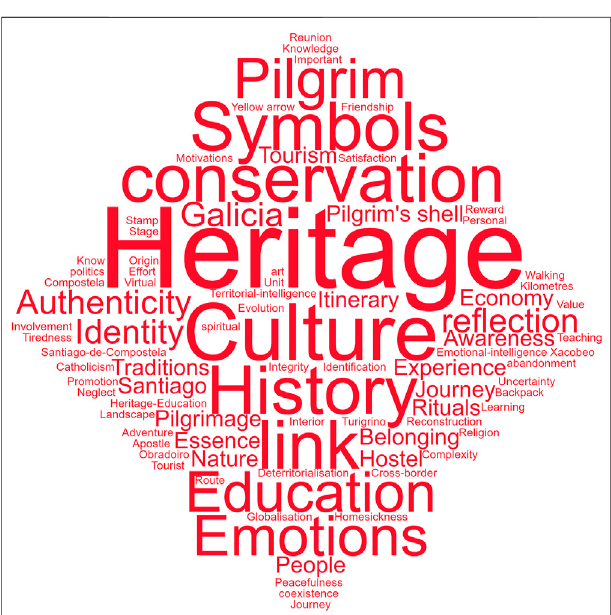
FIGURE 2 | Post-test: Words on the way of St.